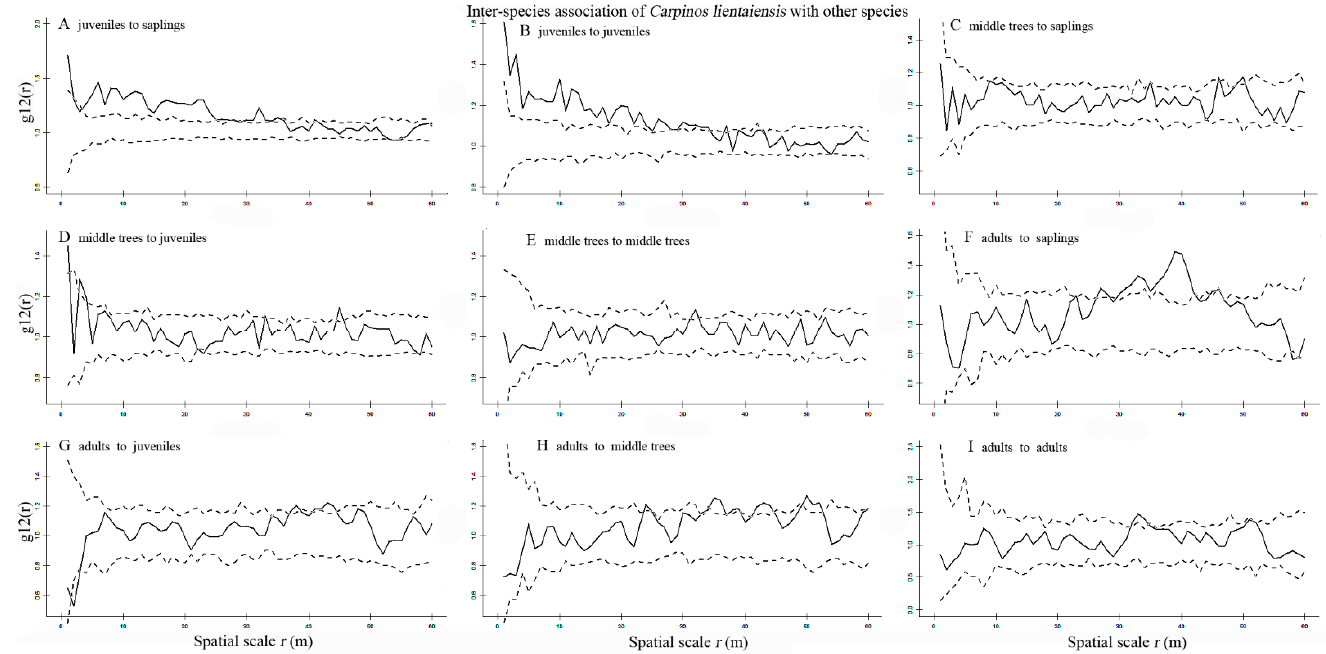
Figure 5. Spatial associations of Carpinus tientaiensis to other trees among different DBH classes in the Carpinus tientaiensis sampling plot. Note: The explanation for all curves and describe each subfigure individually as Figure 4.